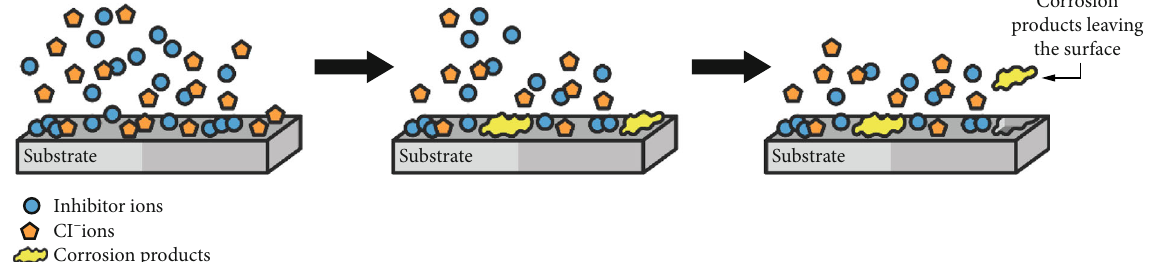
Figure 14: Schematic drawing of proposed processes of formation and migration of corrosion products on metallic surface without coating.